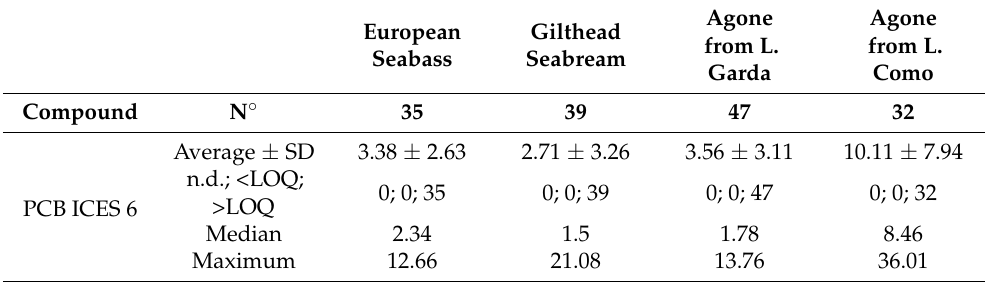
Table 4. Descriptive statistics and the number of not detected, <LOQ, and >LOQ related to the different types of fish. Agone were divided by the lake of origin since there were significant differences between the different lakes. Concentrations are expressed in ng g − 1